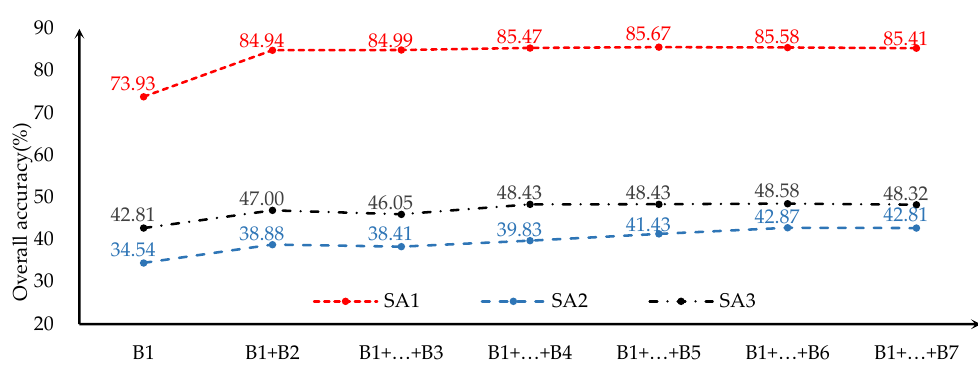
Figure A2. Relationship between accumulated vegetation indices and overall accuracy.